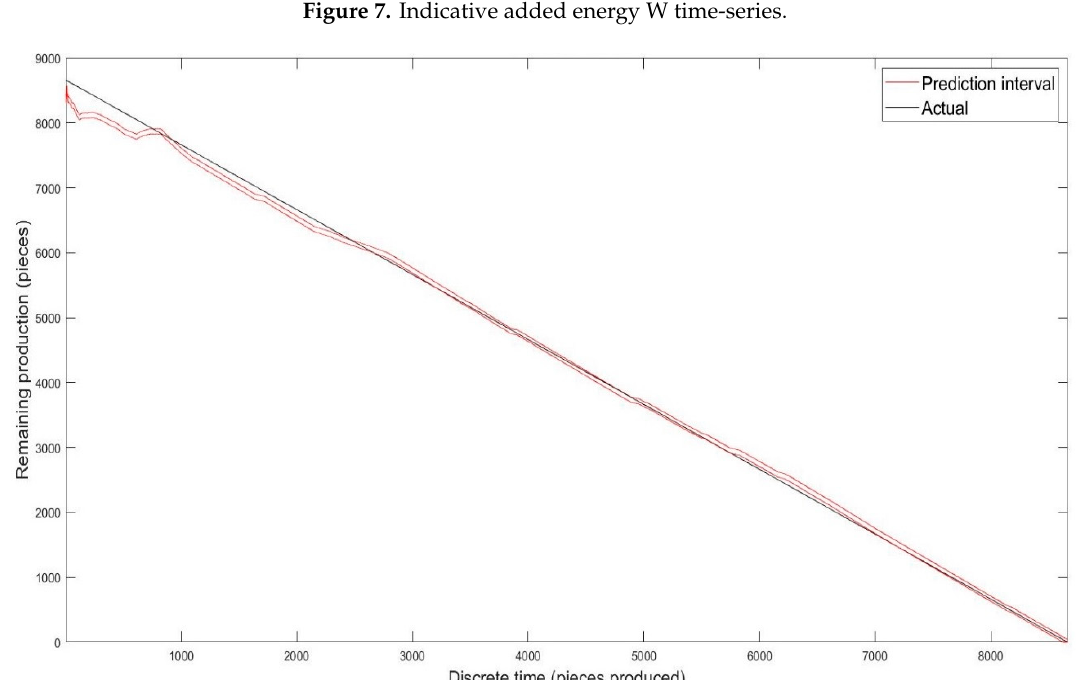
Figure 7. Indicative added energy W time-series.